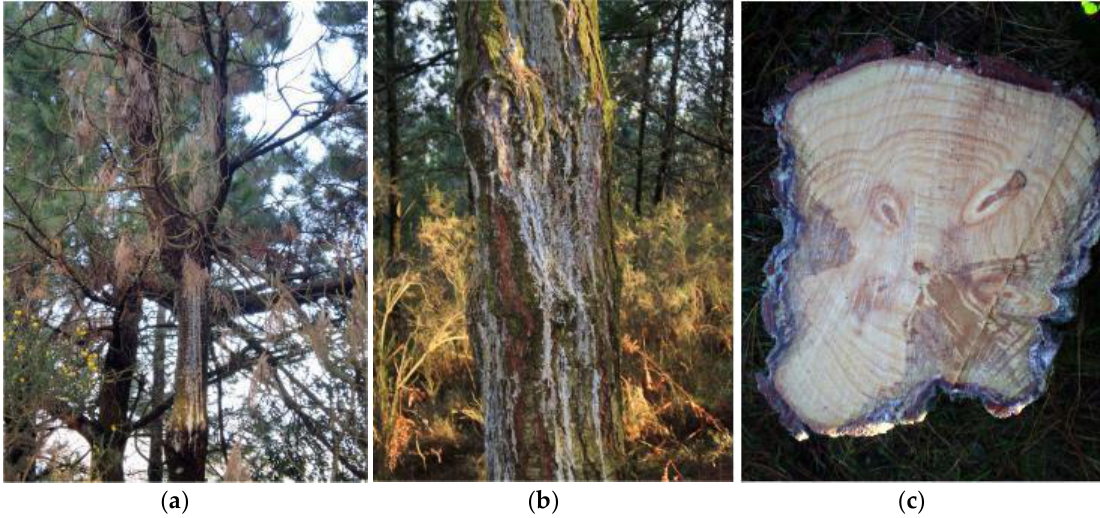
Figure 3. Symptoms of pine pitch canker disease on mature trees: ( a ) infected tree showing branch symptoms and resin flow at on the stem, ( b ) resinous canker on the main stem, ( c ) canker section.